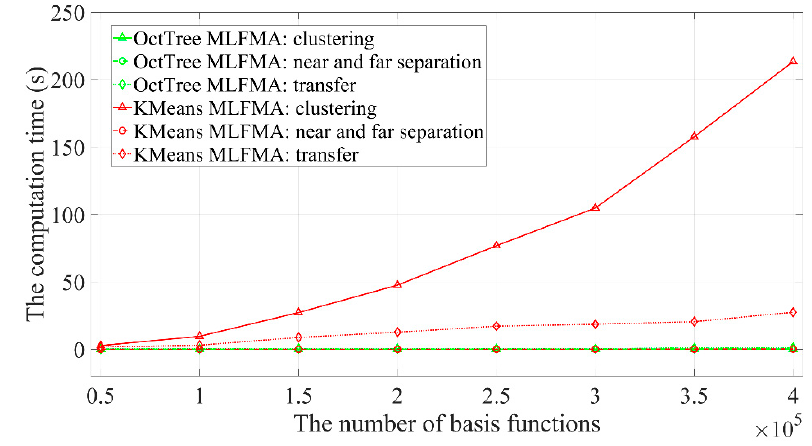
Figure 10. The pre-processing time as a function of the number of basis functions by using the proposed K-Means MLFMA and the conventional octree MLFMA.